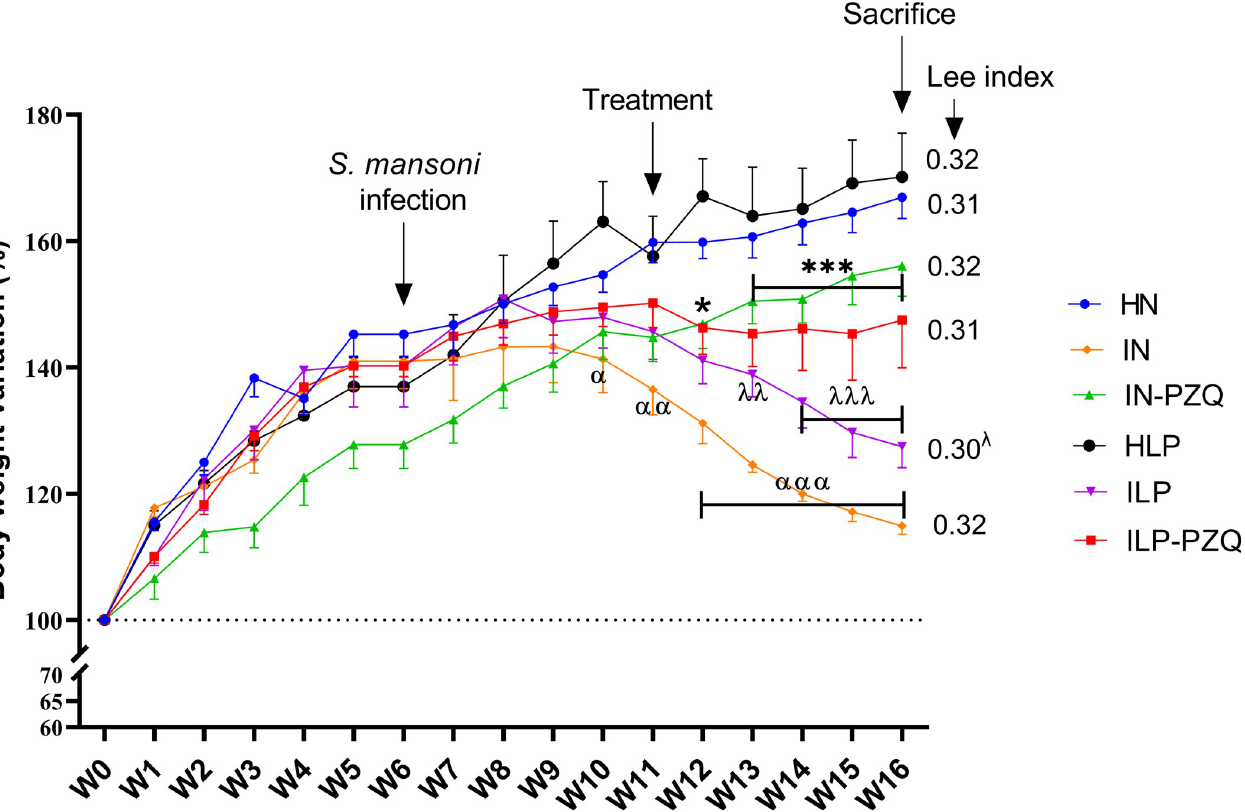
Fig 1. Effects of praziquantel treatment on the body weight variation of Schistosoma mansoni -infected mice receiving a low-protein diet. Data are expressed as mean ± SEM (n = 4–8). Group HN: healthy mice receiving a standard diet; group IN: infected-untreated mice receiving a standard diet; group IN-PZQ: infected mice receiving a standard diet and treated with praziquantel; group HLP: healthy mice receiving a low-protein diet; group ILP: infected- untreated mice receiving a low-protein diet; group ILP-PZQ: infected mice receiving a low-protein diet and treated with praziquantel. ANOVA followed by Turkey’s multiple comparison test. α P < 0.05; αα P < 0.01; ααα P < 0.001: values are significantly different from healthy mice receiving a standard diet (group HN). � P < 0.05; ��� P < 0.001: values are significantly different from the infected-untreated mice receiving a standard diet (group IN). λ P < 0.05; λλ P < 0.01; λλλ P < 0.001: values are significantly different from healthy mice receiving a low-protein diet (group HLP).